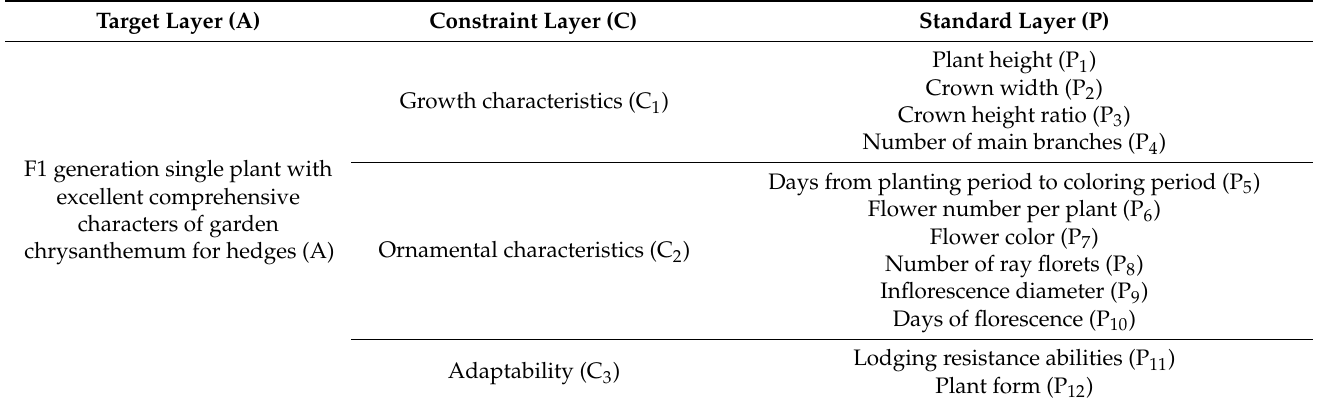
Table 4. The hierarchy model of evaluation system.